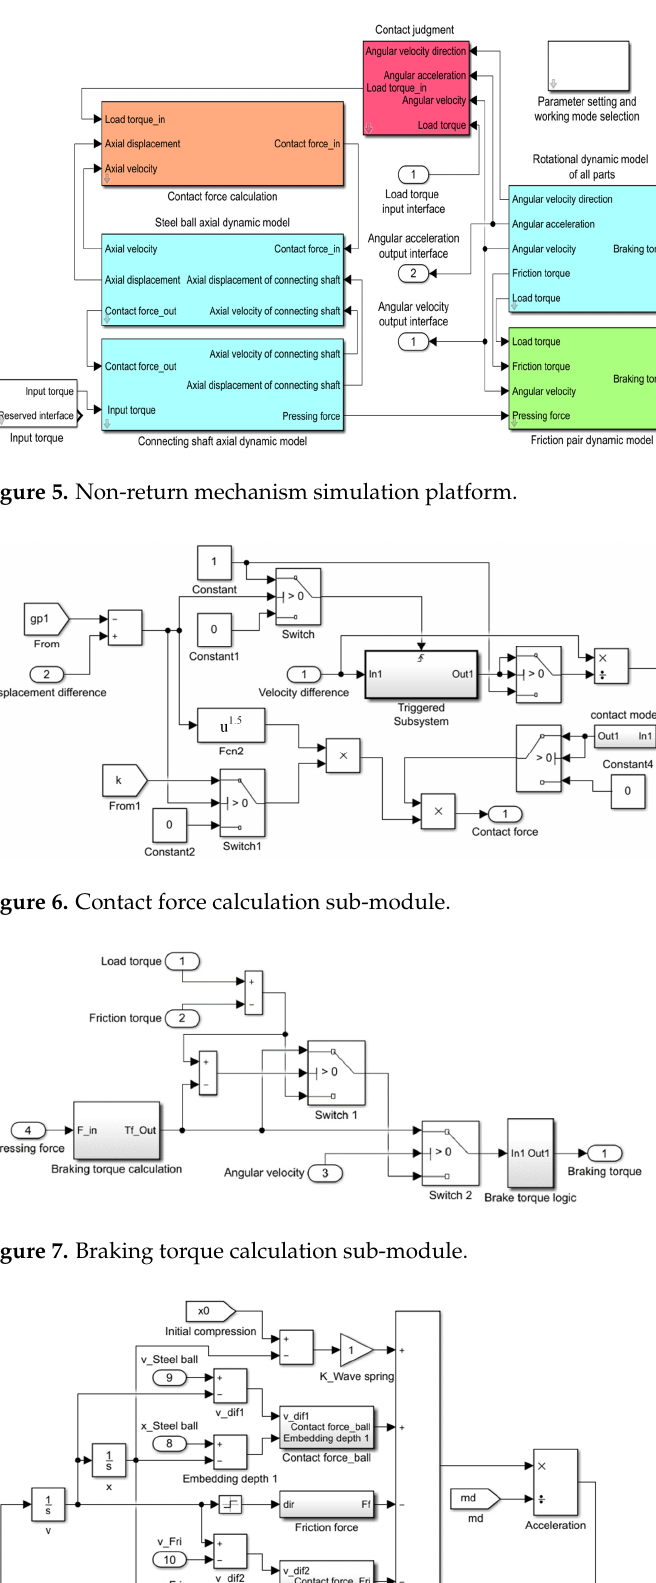
Figure 8. Axial dynamic model sub ‐ module of connecting shaft.